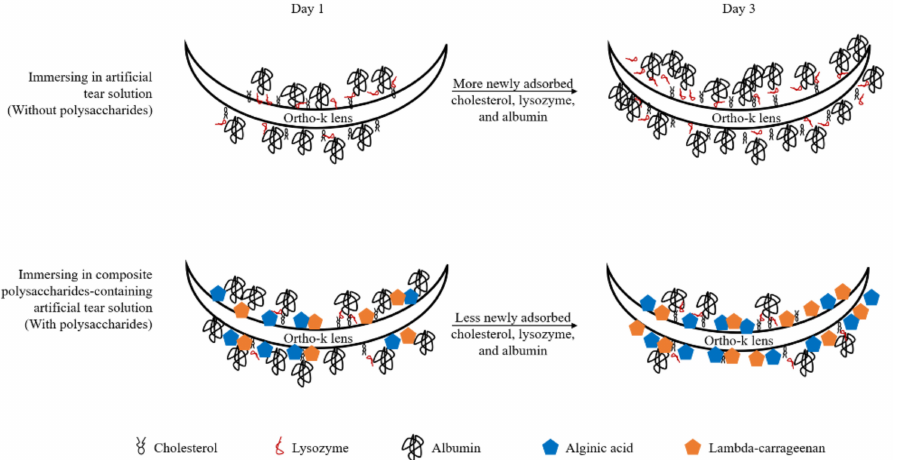
Figure 6. The potential mechanism of how alginic acid and lambda-carrageenan weakly prevent adsorption of cholesterol and strongly inhibit protein (especially albumin)